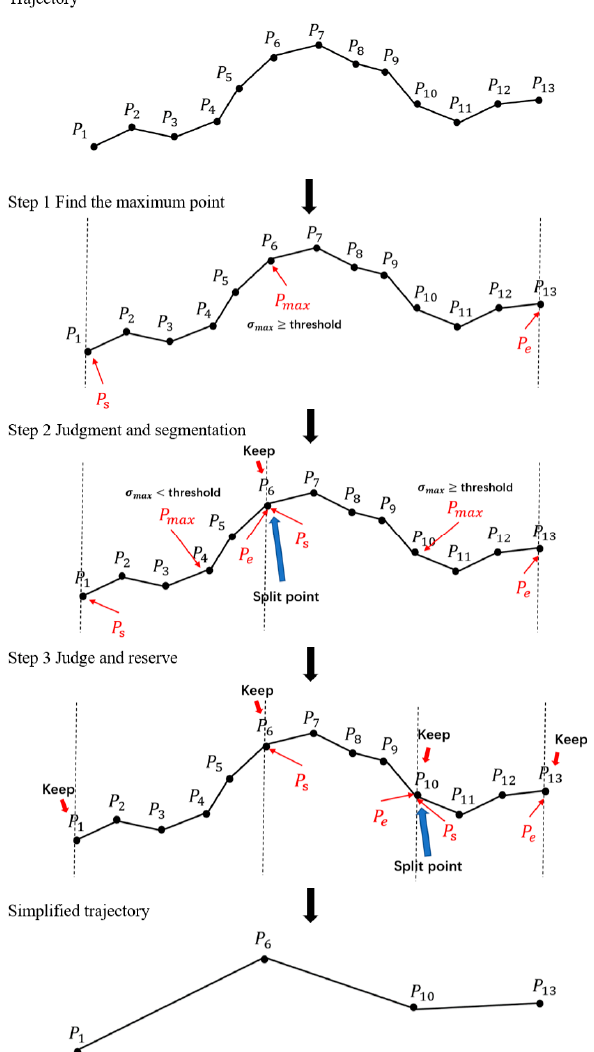
Figure 2. Schematic diagram of the trajectory simplification process. There are 13 trajectory points.